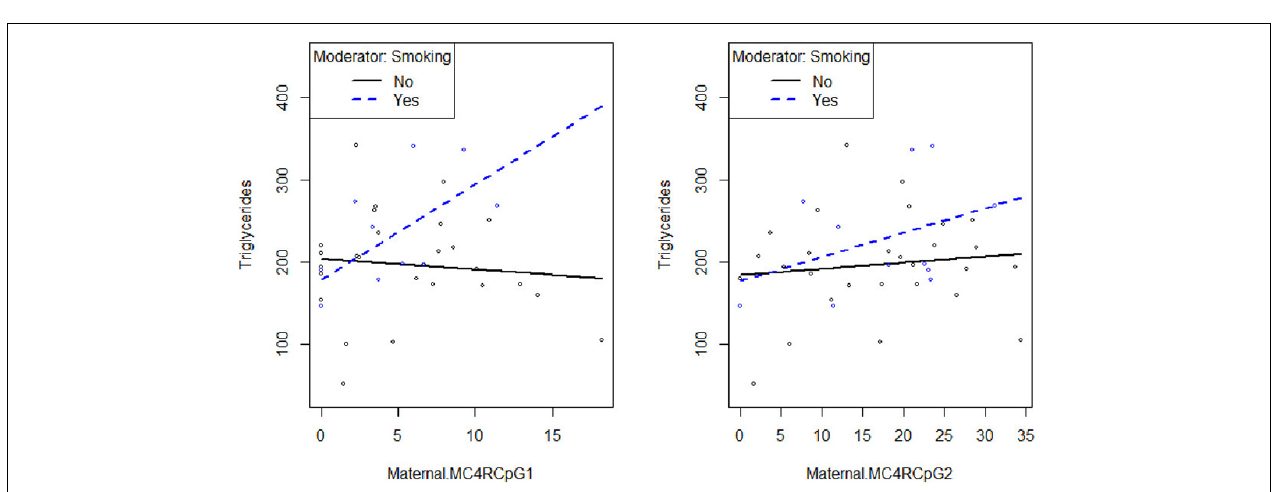
FIGURE 2 | Smoking habit moderates the relation between MC4R DNA methylation at CpG1on the maternal side and TG at the third trimester of pregnancy ( β smoking = yes ∗ CpG1 DNA methylation = 12.94, p =